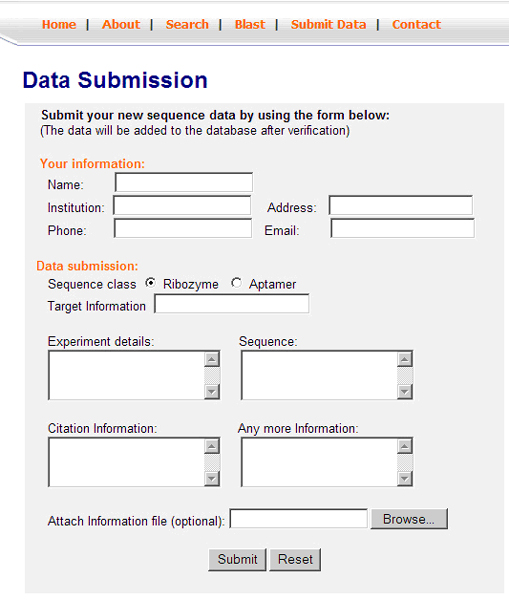
View of the data submission form by the user.